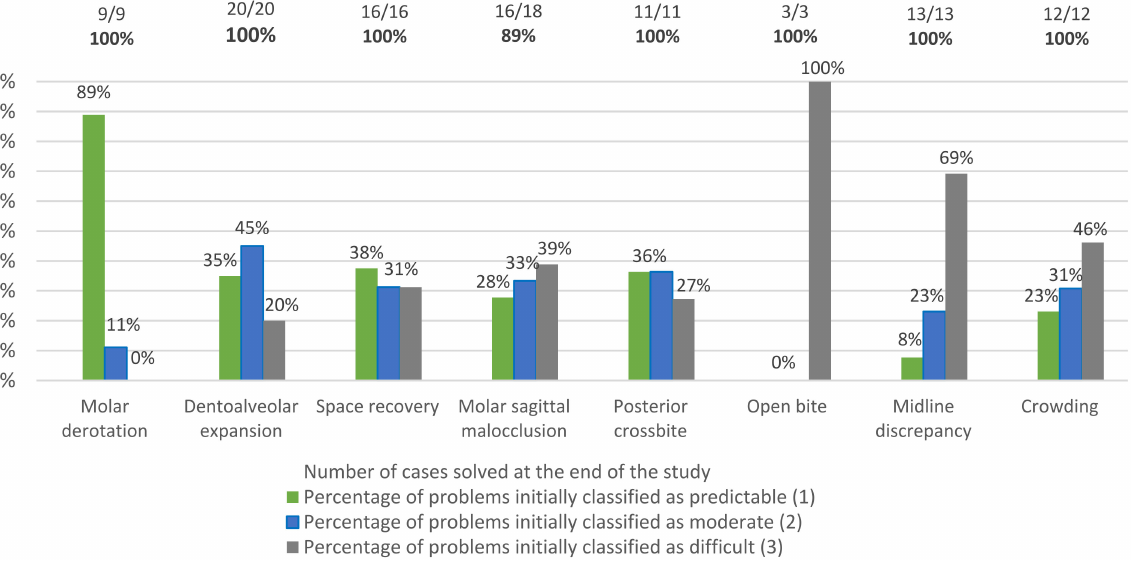
Figure 3. Percentages of malocclusion traits corrected at the end of the study according to the problem